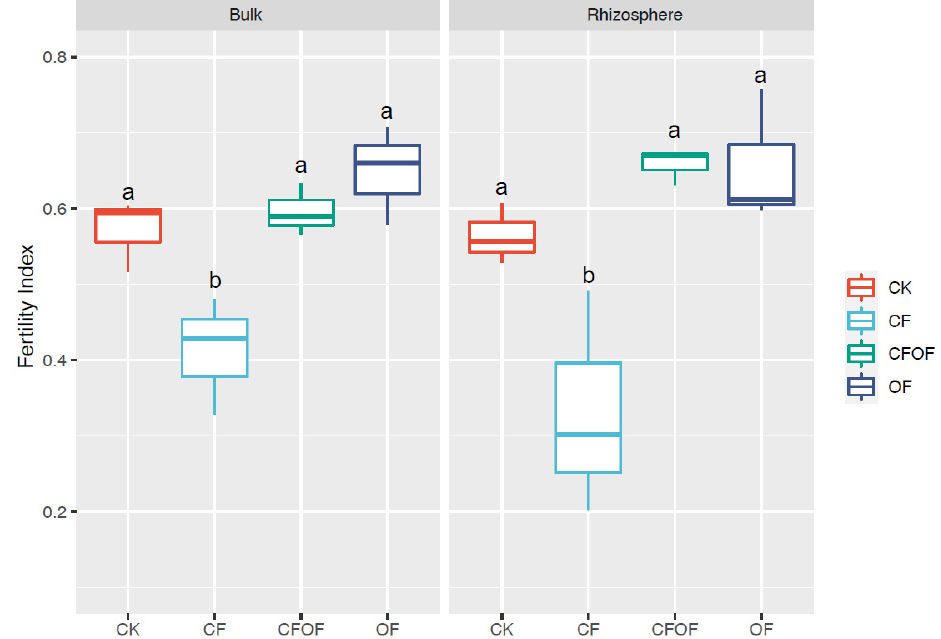
Figure 1. Soil fertility index in bulk and rhizosphere soil under different fertilization treatments. CK, control treatment; CF, 100% chemical fertilizer; CFOF, 50% chemical fertilizer + 50% bio-organic fertilizer; OF, 100% bio-organic fertilizer. Different letters in rows indicated the significant differences at p < 0.05.